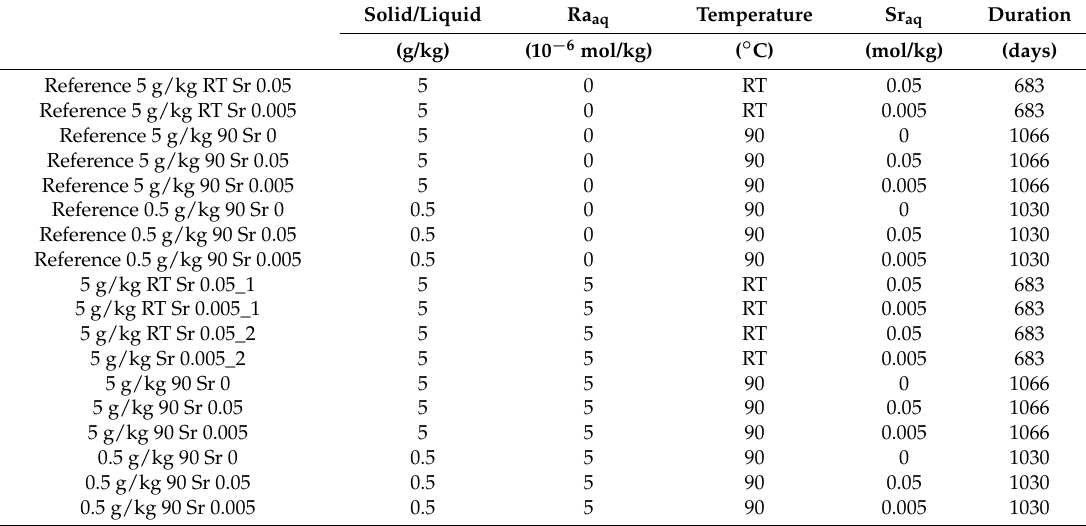
Table 2. Overview of experiments with Sr in the aqueous